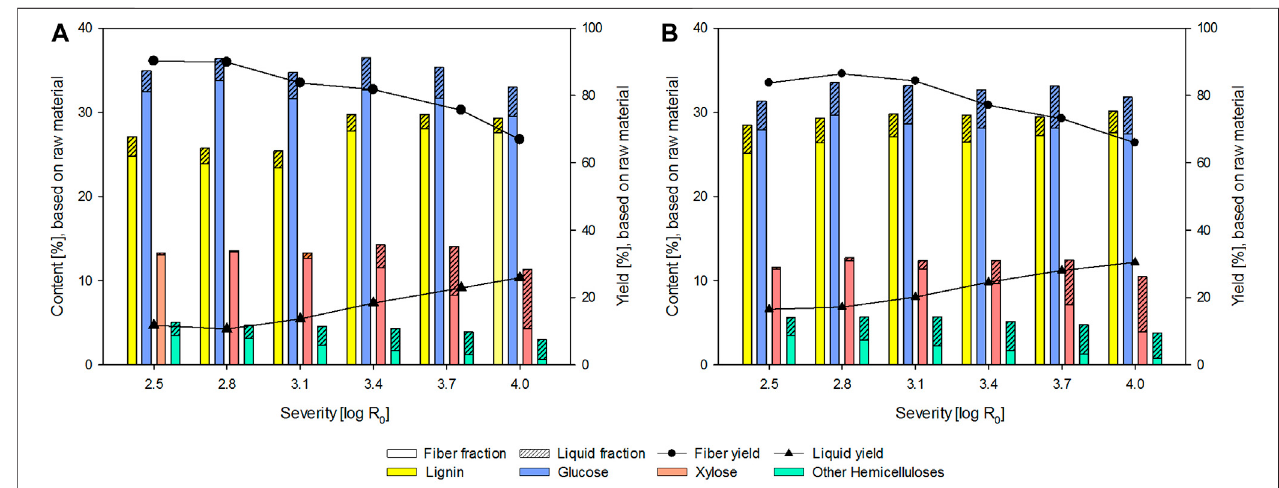
FIGURE2| Yield and compositionofthe fi bers and liquor after steam re fi ning ofsamplematerial collectedin winter (A) and summer (B) (% based onraw material).